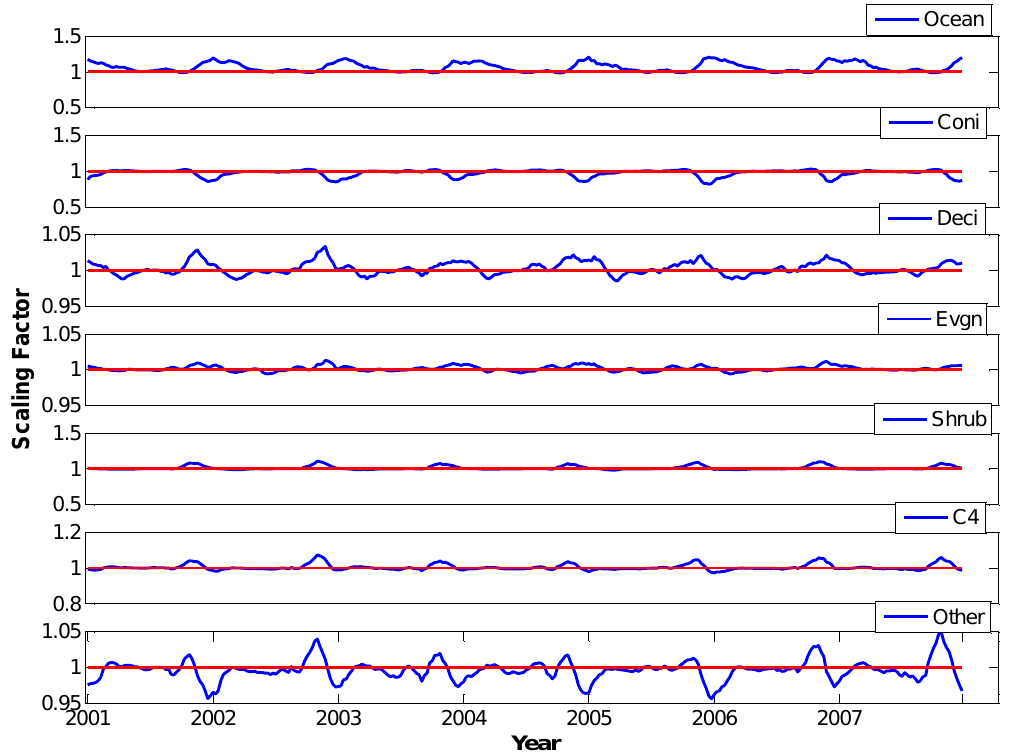
Figure 4. The results of optimized weekly scaling factors in the 20th latitude zone, where Coni stands for coniferous forest, Deci for deciduous forest, Evgn for evergreen forest, Shrub for shrubland, C4 for C4 vegetation and Other for other vegetation. Blue lines are estimated parameters, while red lines are constants which equal 1. Note that different scales are